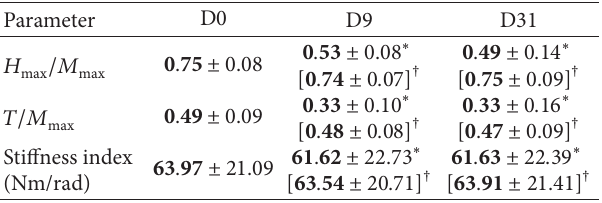
Table 3: Variation of electrophysiological ratios calculated for the soleus muscle and passive stiffness of the ankle (mean ± standard deviation) during the 1 Hz and 10 Hz ( † brackets) stimulation protocols: before (D 0 ) and after (D 9 : early assessment; D31: late assessment).